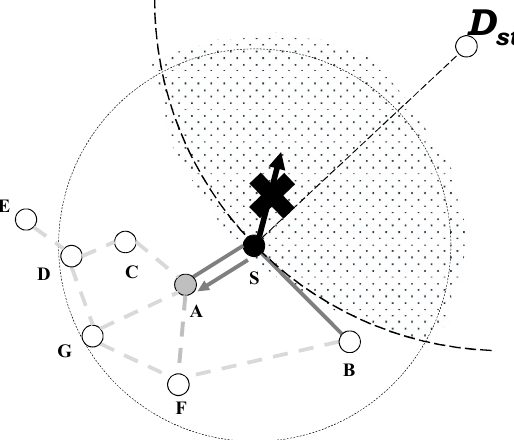
Figure 3. After the node S fails greedy forwarding, it finds the candidate node A by using face-routing with the search